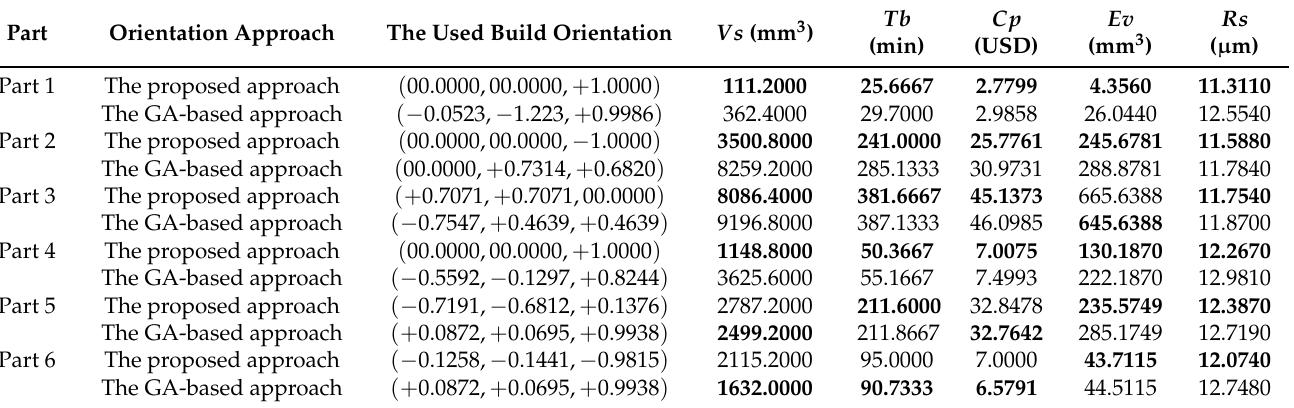
Figure 12. Twelve printed parts. ( a ) A part printed in the optimal orientation determined by the pro- posed approach. ( b ) A part printed in the optimal orientation determined by the GA-based approach. Table 3. Results of the effectiveness comparison based on printing